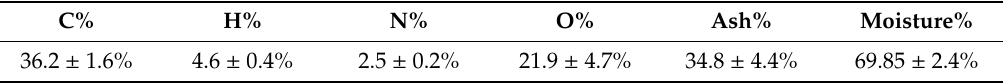
Table 4. Ultimate analysis (dry basis) and moisture content of digestate.